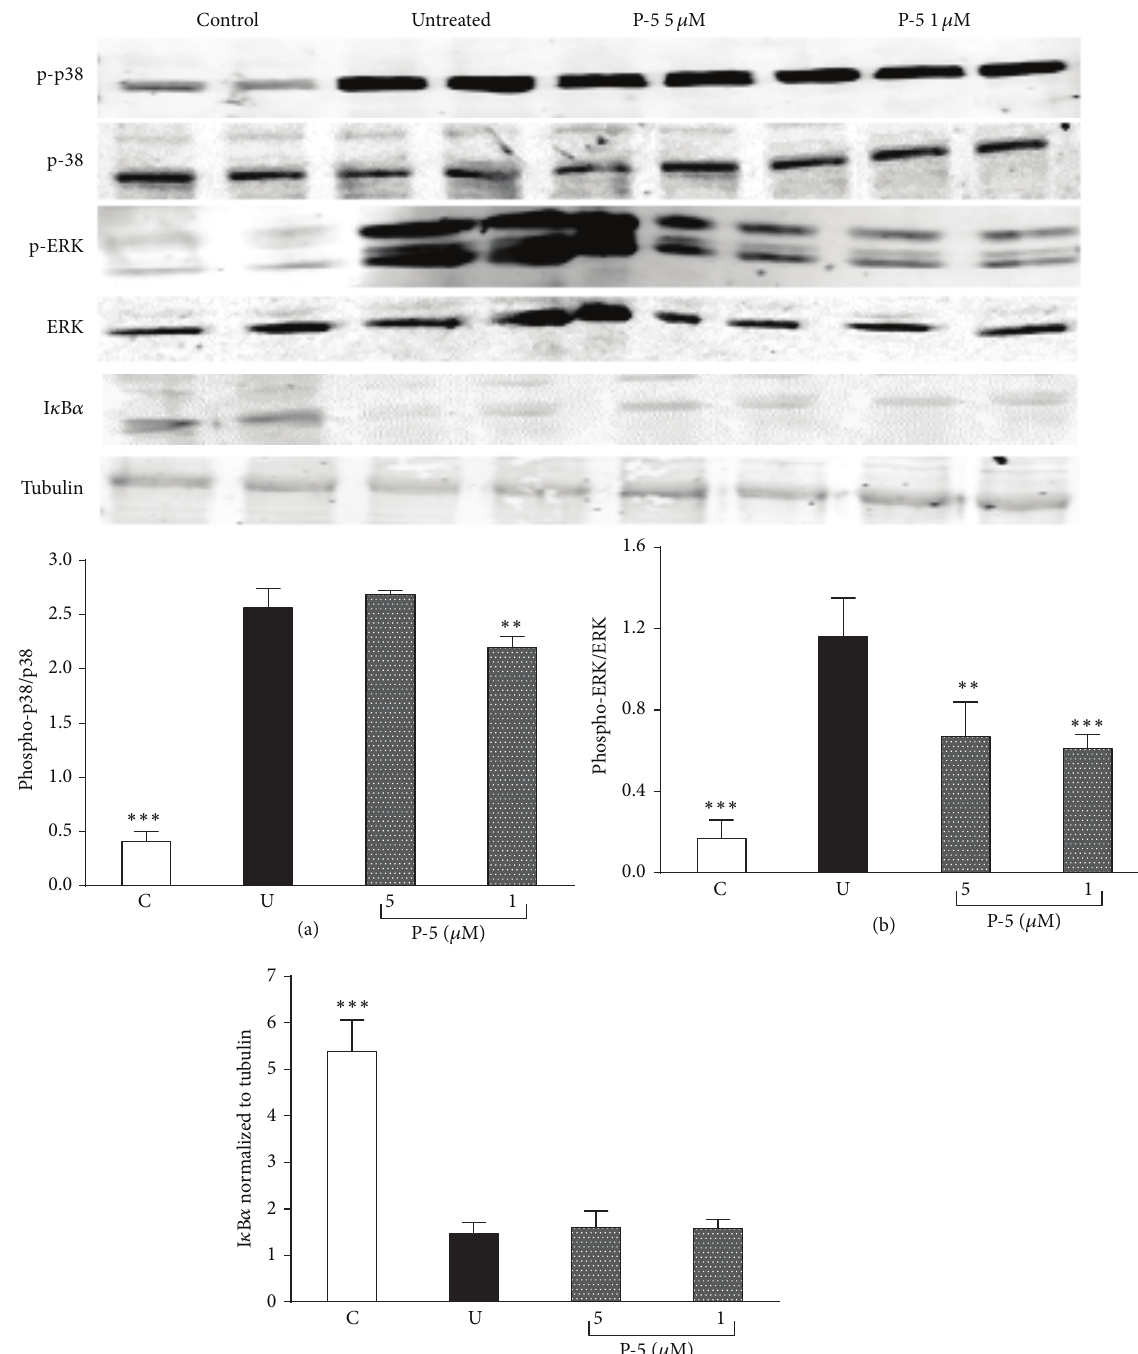
Figure 5: Western blot and densitometry analysis of p-p38 (normalized to p38; (a)), p-ERK (normalized to ERK; (b)), and I 𝜅 B 𝛼 (normalized to tubulin; (c)) in activated macrophages lysates after incubation with 1 or 5 𝜇 M of P-5. C: naive control; U: untreated control. Shown are the mean ± S.D results. of 4–6 measurements. ANOVA of the effect of 1 and 5 𝜇 M of P-5 on the tested regulatory proteins were F 3,16 = 353.02 𝑝 < 0.00001 for ERK, and F 𝑝 < 0.00001 for I 𝜅 B 𝛼 . ∗∗ 𝑝 < 0.01 ; ∗∗∗ 𝑝 < 0.001 ; compared to 𝑝 < 0.00001 for p-38, F 3,20 = 47.19 3,16 = 97.01 untreated